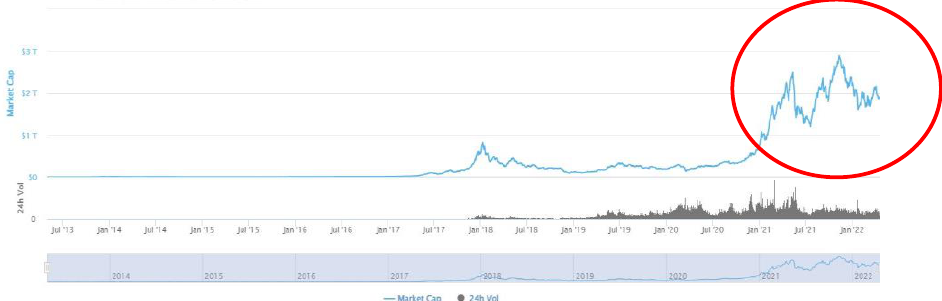
Figure 3. Debt or contract relief during the COVID-19 pandemic. Source: Authors’ calculations based on the OxCGRT. https://ourworldindata.org/covid-income-support-debt-relief (accessed on 15 April 2022).